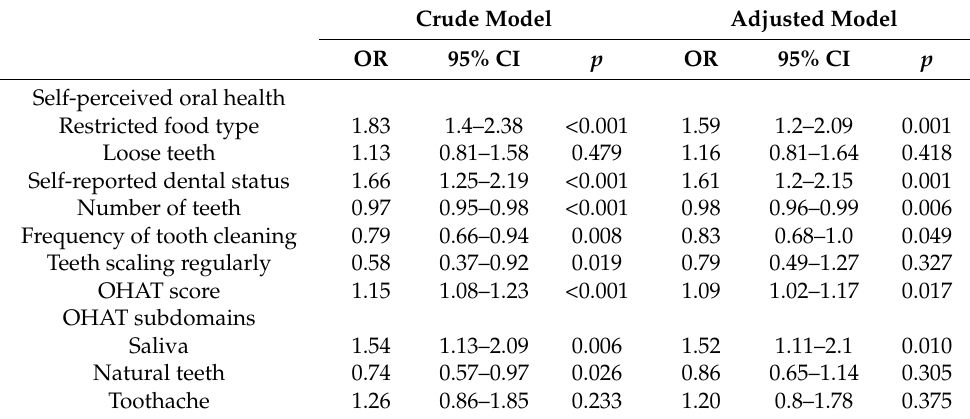
Table 4. Relationship between oral health and physical